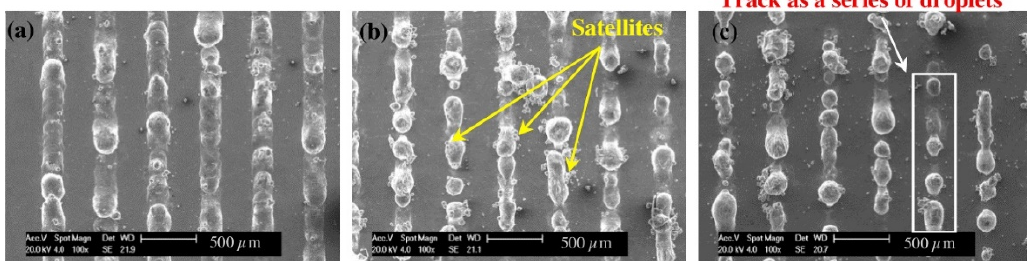
Figure 37. AlSi10Mg single tracks showing the variations in the shape of the fusion line and the defect formation as a function of laser scan speed ( a ) 250 mm/s, ( b ) 500 mm/s and ( c ) 750 mm/s [167].